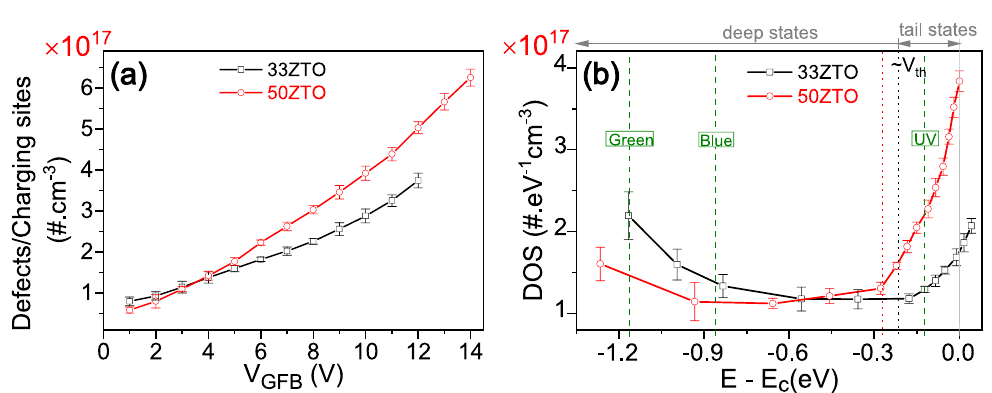
Figure 7. ( a ) The extracted sub-bandgap defects/charging sites density as a function of V GFB (= V G − V FB ) for 33ZTO and 50ZTO TFTs. ( b ) The extracted density of sub-bandgap states (DOS) versus energy with reference to the conduction band minima. The green dashed lines represent photoexcitation energy levels for the 33ZTO at UV, blue and green light